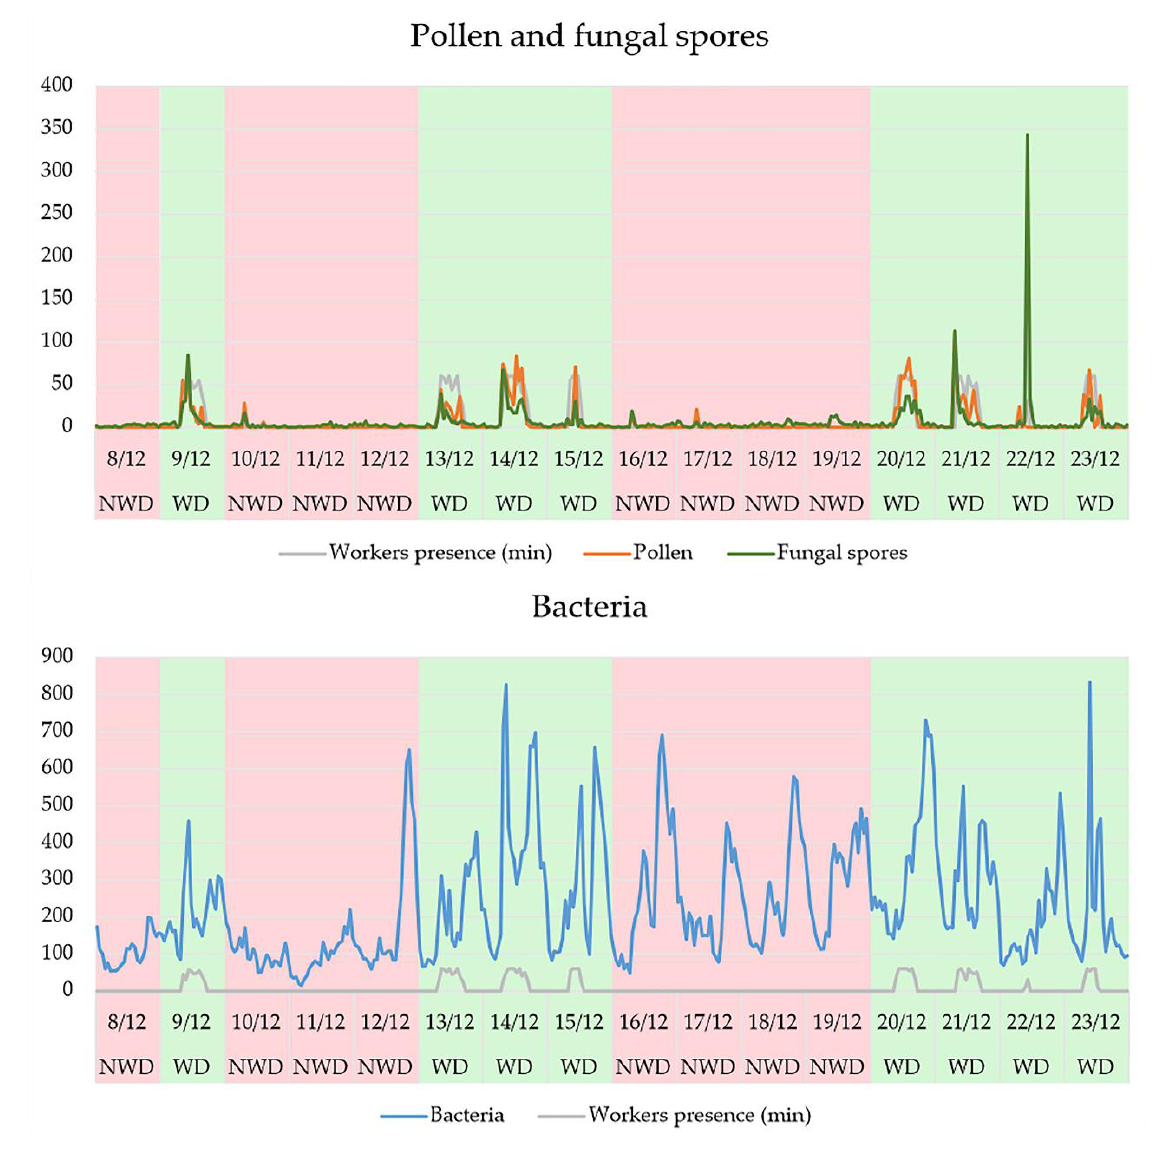
Figure 11. Number of pollen grains, fungal spores and bacteria ( y -axis) sampled hourly for each day ( x -axis); grey lines represent the presence of workers in the room (minutes).